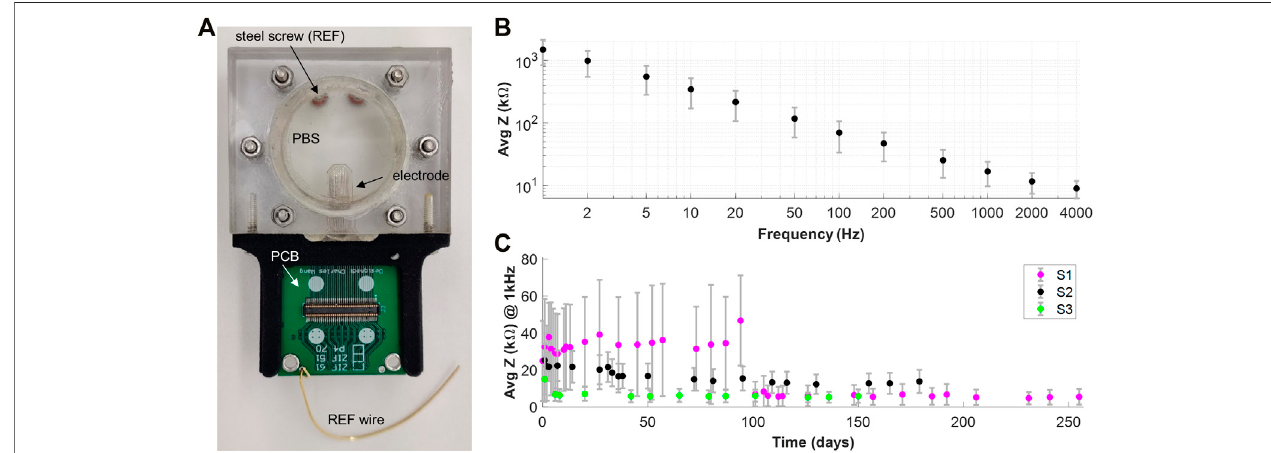
FIGURE 4 | Impedance Measurements. (A) Soaking case setup for accelerated aging tests. An acrylic case with a circular window holds the electrode array in saline.Theoutsideofthecaseissealedwithsilicone(Sylgard184)toavoidevaporationofthesaline.Asteelscrewimmersedintothesalineactsasareferenceelectrode. The PCBallows connection of the electrode array for impedance measurementswithout ever extracting it from the soak case. The soak case was kept at 60 ֠ C for these recordings for accelerated aging. (B) EIS measurements of a monolayer silicone electrode array. (C) Accelerated aging tests results for 3 monolayer silicone electrode arrays.